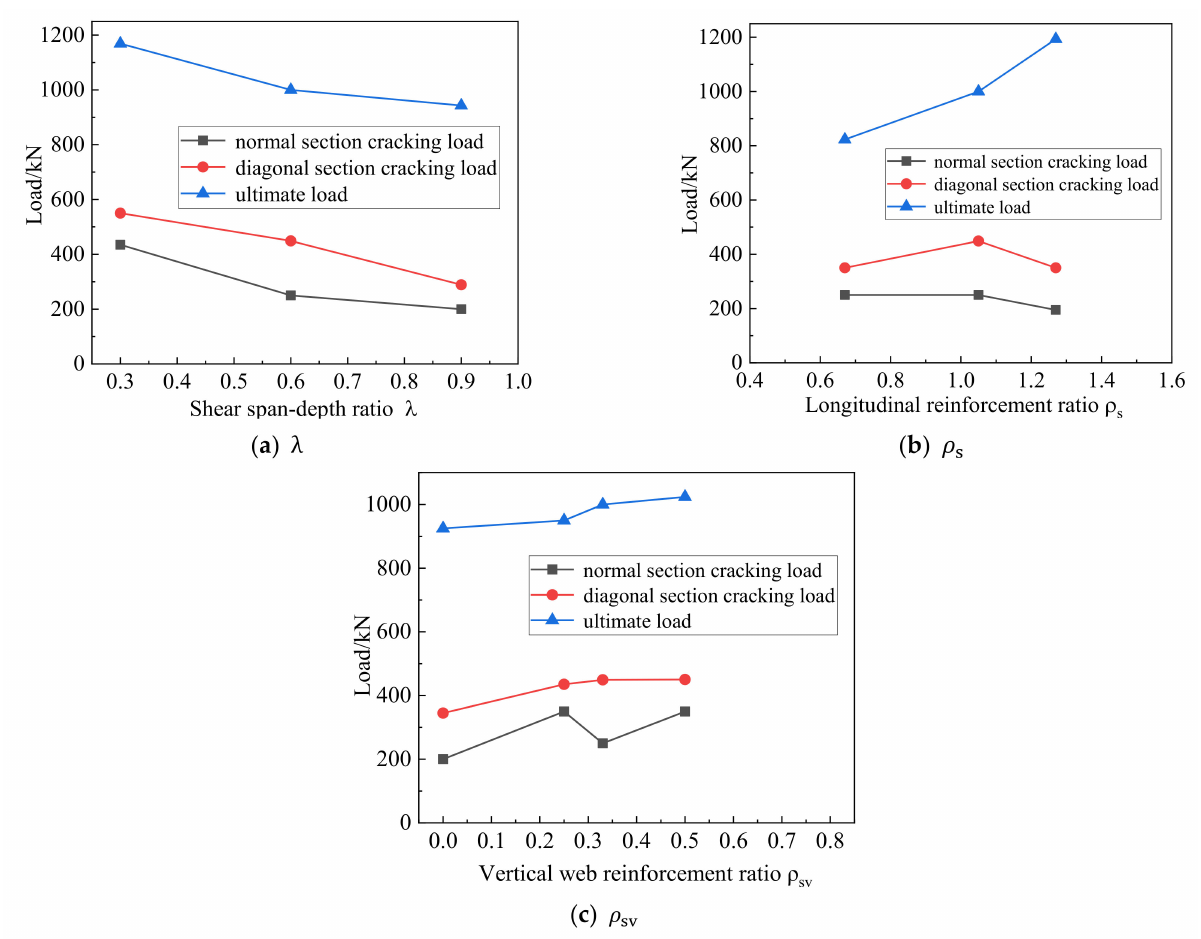
Figure 14. Relation curve between three variables and